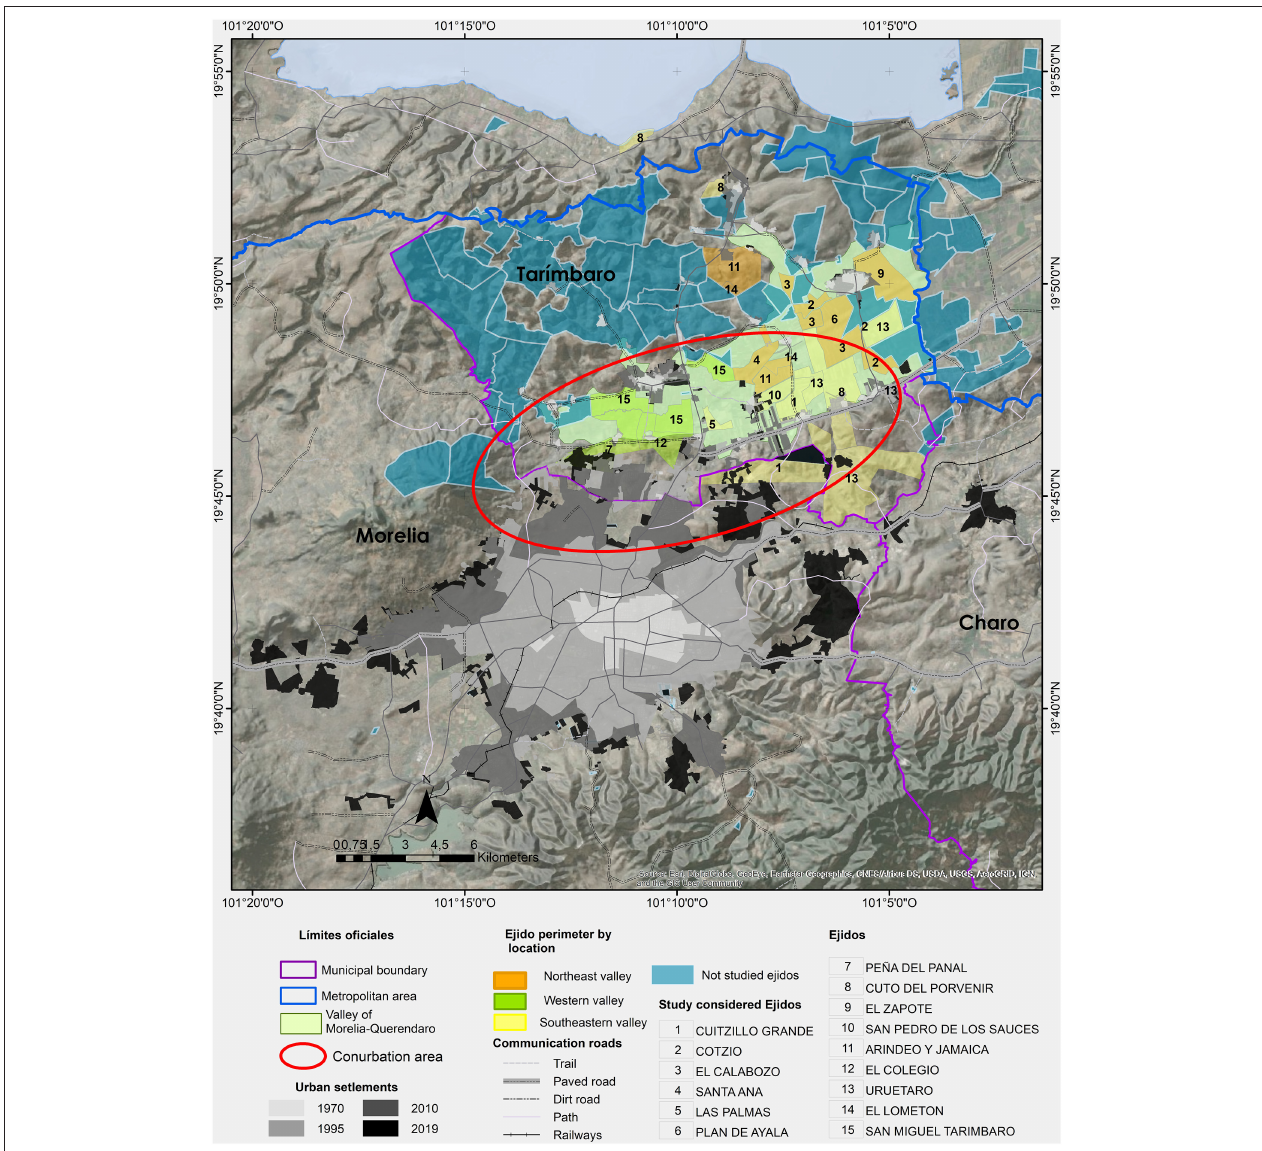
FIGURE 4 | Distribution of the ejidos